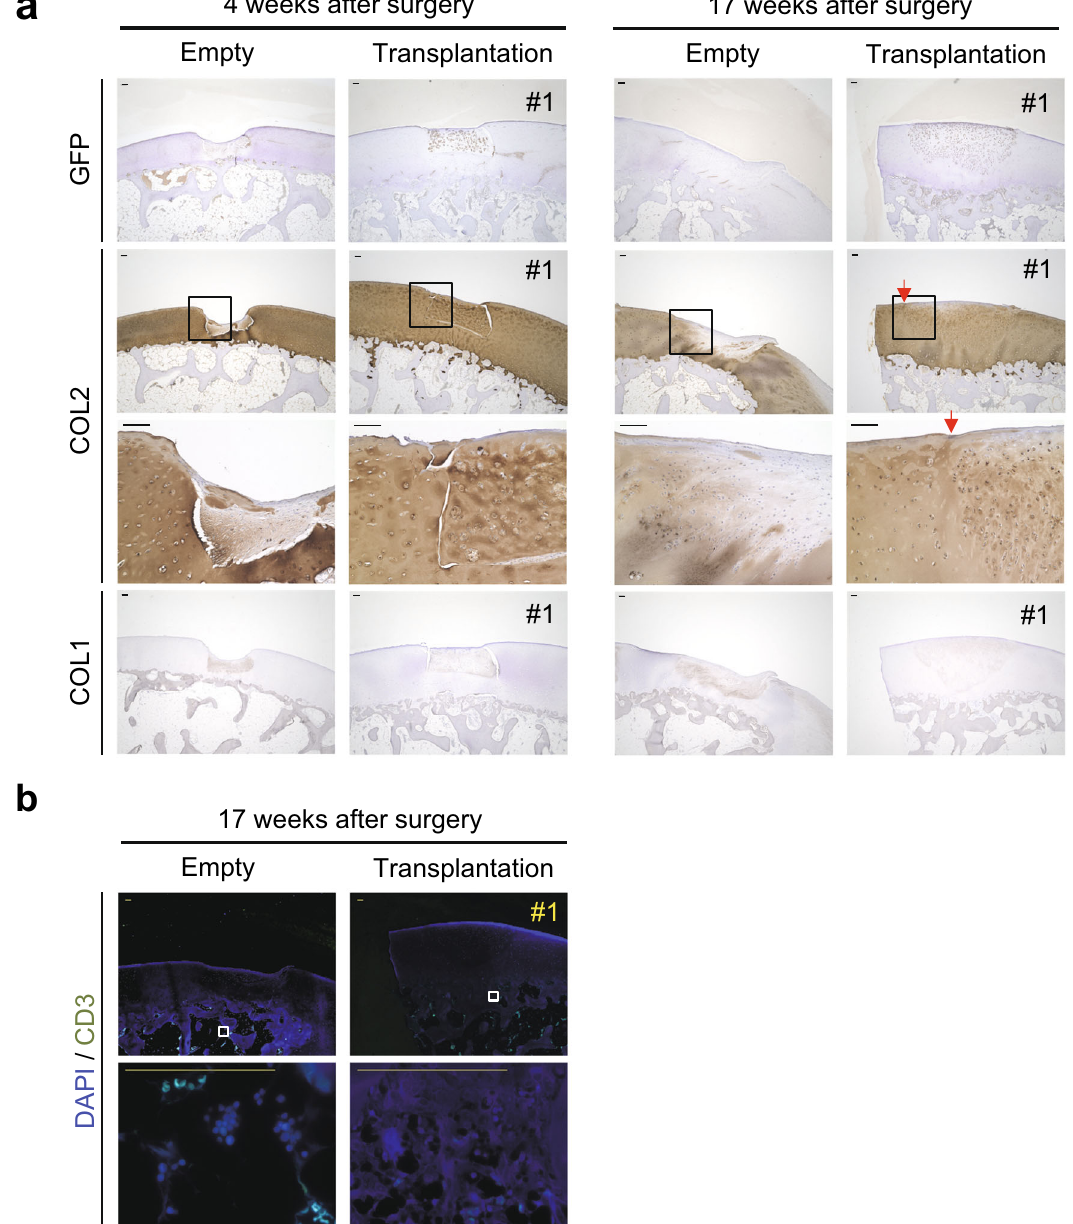
Fig. 4 | Immunohistochemical staining ofrepairedchondral defects. a Samples were harvested 4 or 17 weeks after transplantation. Semi-serial sections were immunostained for GFP, type II collagen (COL2), and type I collagen (COL1). The boxed regions in the second row are magni fi ed in the third row. Data were